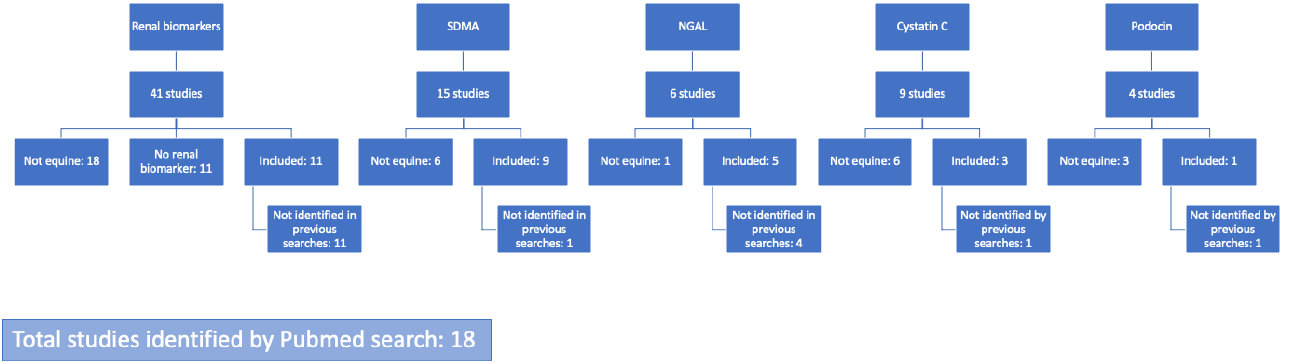
Figure 1. Flow diagram of the literature search for studies on biomarkers on equine kidney disease. SDMA—symmetric dimethylarginine; NGAL—neutrophil gelatinase-associated lipocalin. Searches were always in combination with the search word horse or equine.